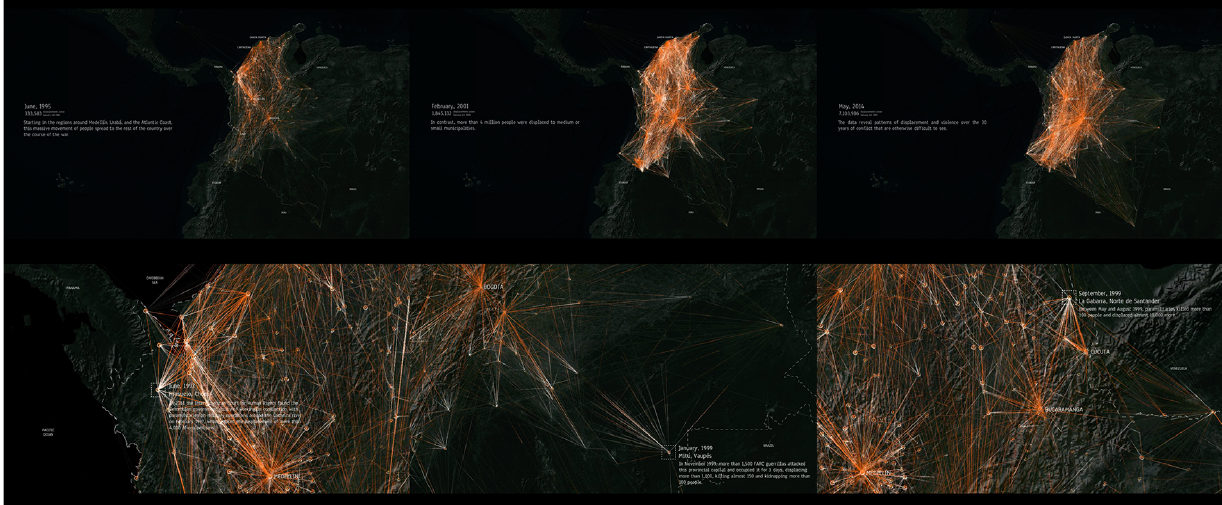
Figure 2. Screenshots of animation (zoomed out and